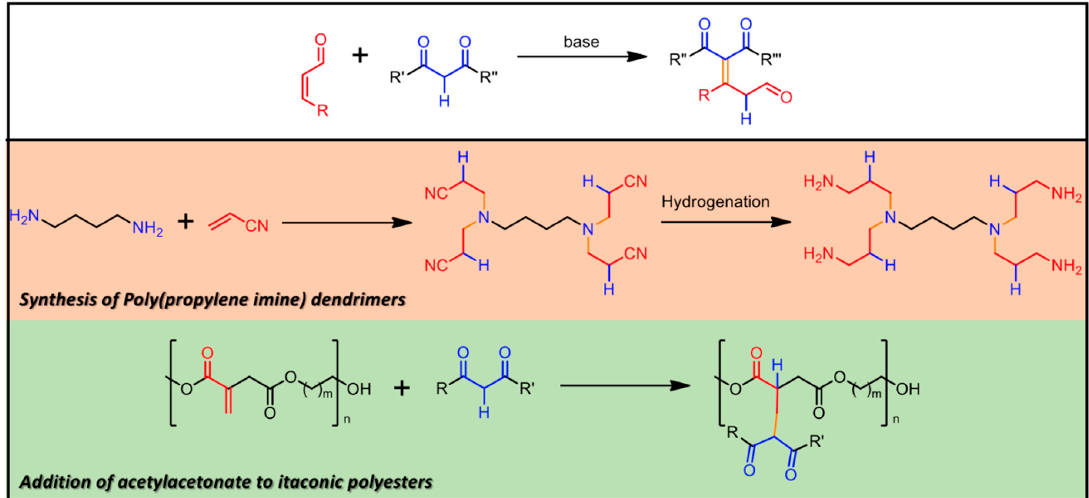
Figure 5. Michael Addition Reaction General Scheme. Middle and bottom: examples of some industrially relevant materials, whose synthesis takes advantage of Michael Addition. In evidence, the newly formed chemical bond (orange) and the residues belonging to the starting carbonyl (red) and 1,3-diketo (blue) moieties.